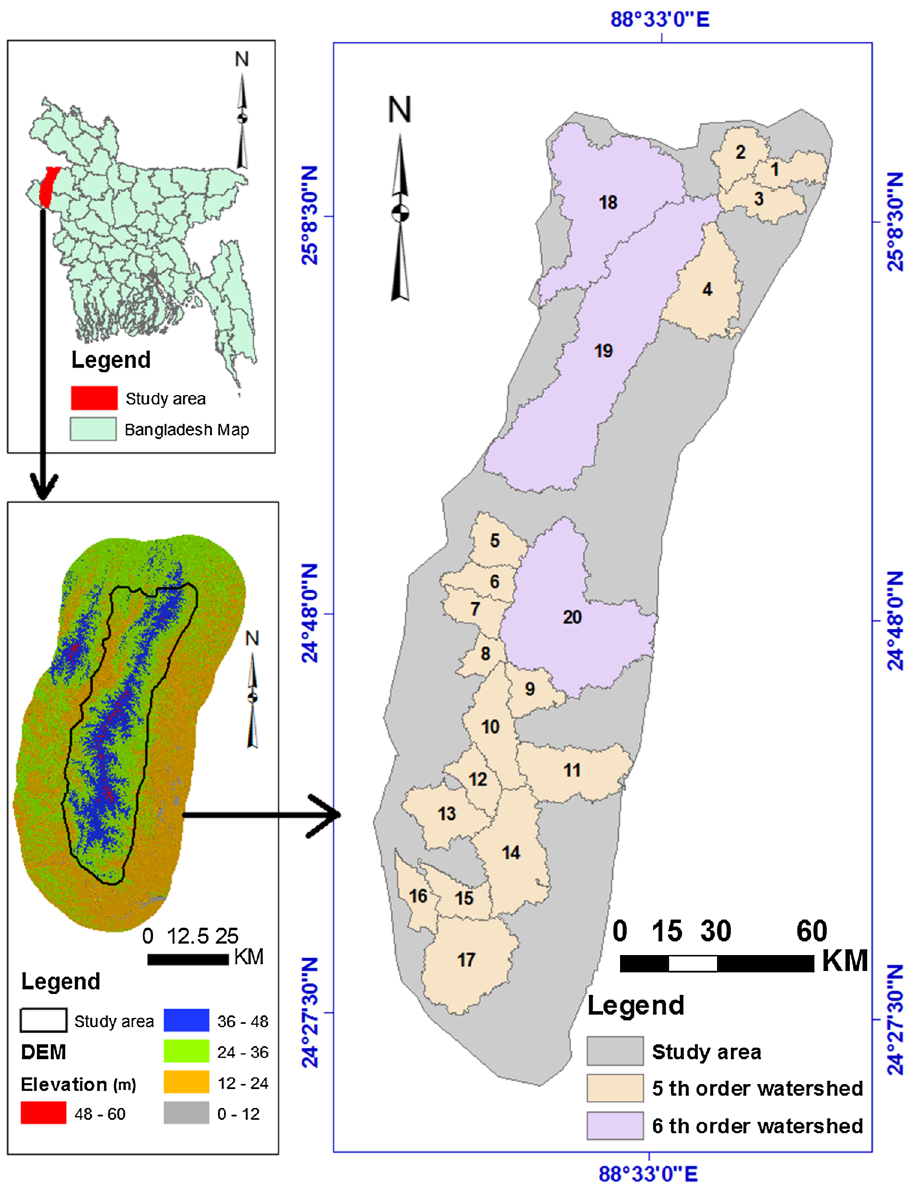
Fig. 1 Map of study